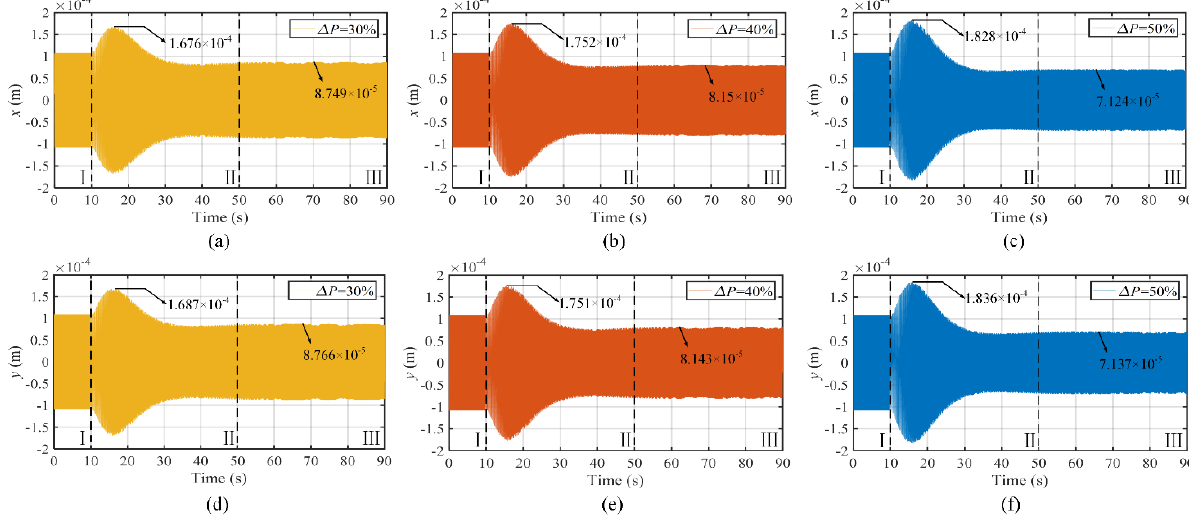
Figure 11. The axis trajectory of the hydro-turbine runner under different sudden load increasing amounts. ( a ) Δ P = 30%; ( b ) Δ P = 40%; ( c ) Δ P = 50%.